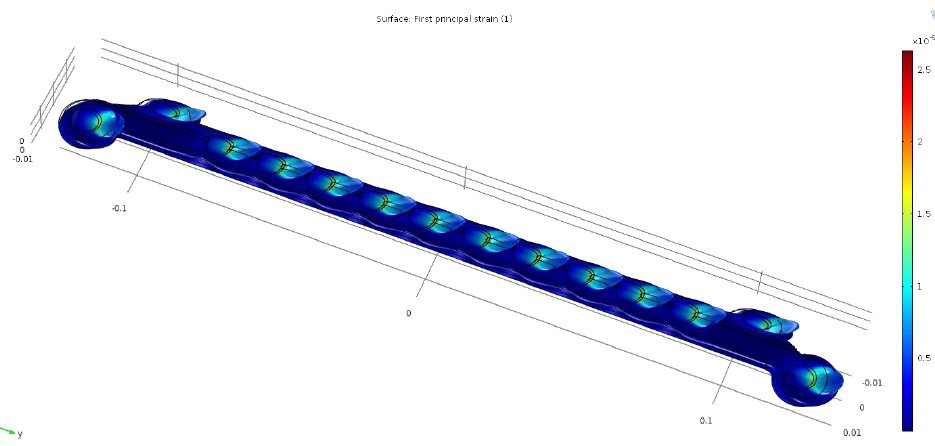
Figure 20. First principal strain of newly developed plate bent for 30°.